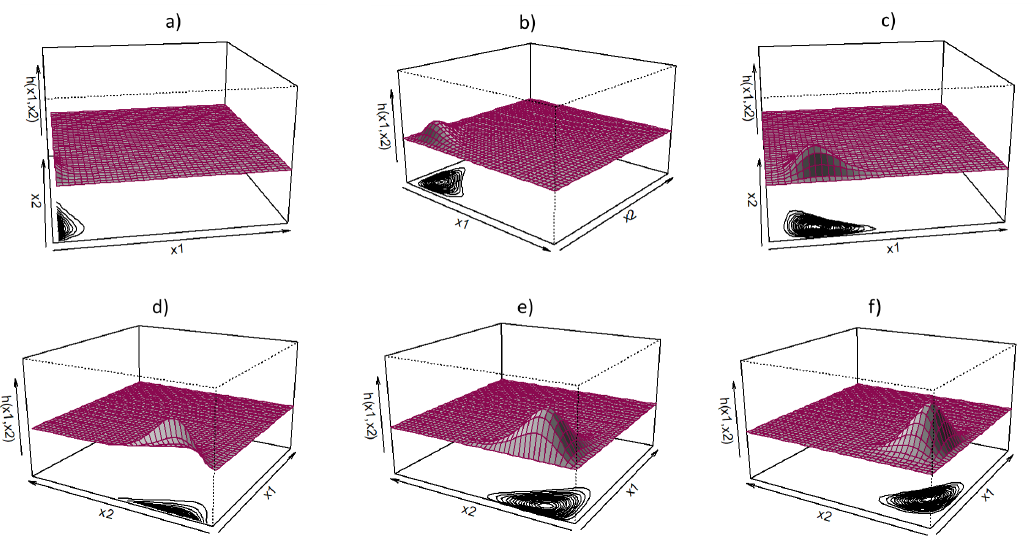
Figure 2. Example pdfs and contour plots for ( 10 ) for ( α 1 , α 2 , α 3 , δ 1 , θ 1 , δ 2 , θ 2 , λ ) when ( a ) (0.1,2,2,2,2,2,2,2), ( b ) (2,2,2,2,2,2,2,2),